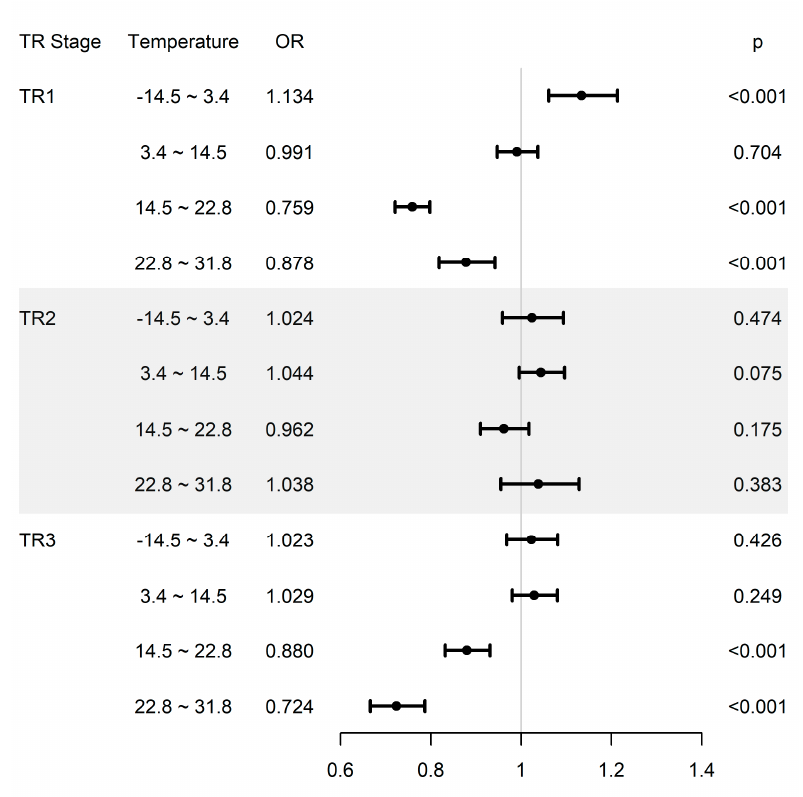
Figure 1. The combined effect of temperature (°C) and PM 2.5 (×10 µg/m 3 ) in each trimester on the risk of preterm birth. These results are based on the adjusted Model 2, including PM 2.5 and temperature exposures of all three trimesters, and this results assume the interactions between PM 2.5 and temperature in each trimester. The model adjusted for sex, mother’s age, mother’s educational level, parity, and birth season.